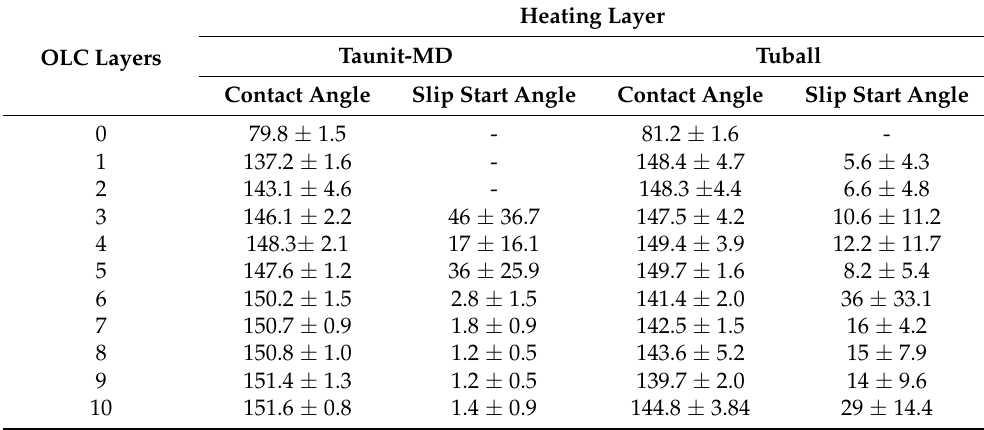
Table 1. Hydrophobic and electrophysical properties of samples, sputtered without an interface layer. A dash means that the drop did not slip.